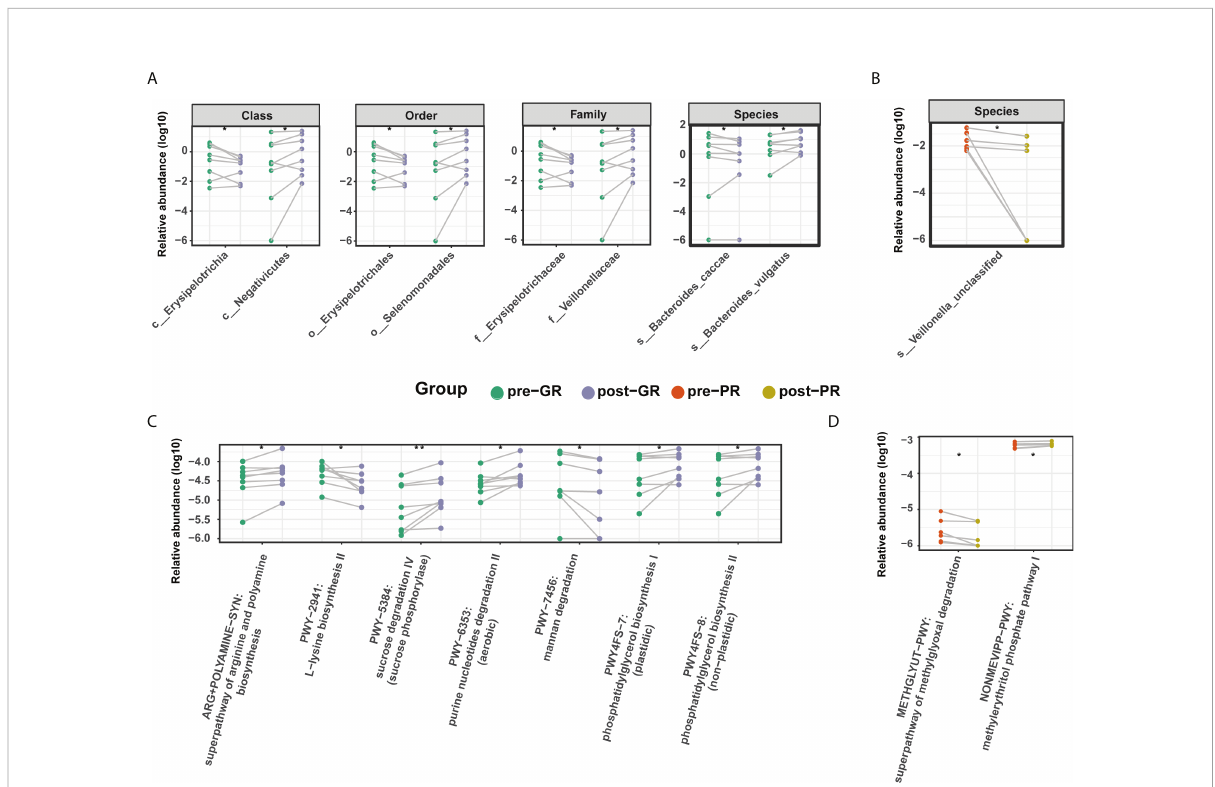
FIGURE 5 Differential microbiome features before and after MTX treatment. (A, B) Differential taxa identi fi ed in the GR group (A) and PR group (B) ; (C, D) Differential microbial metabolic pathway identi fi ed in the GR group (C) and PR group (D) . Signi fi cance is determined by the paired Wilcoxon test. * p < 0.05; ** p <